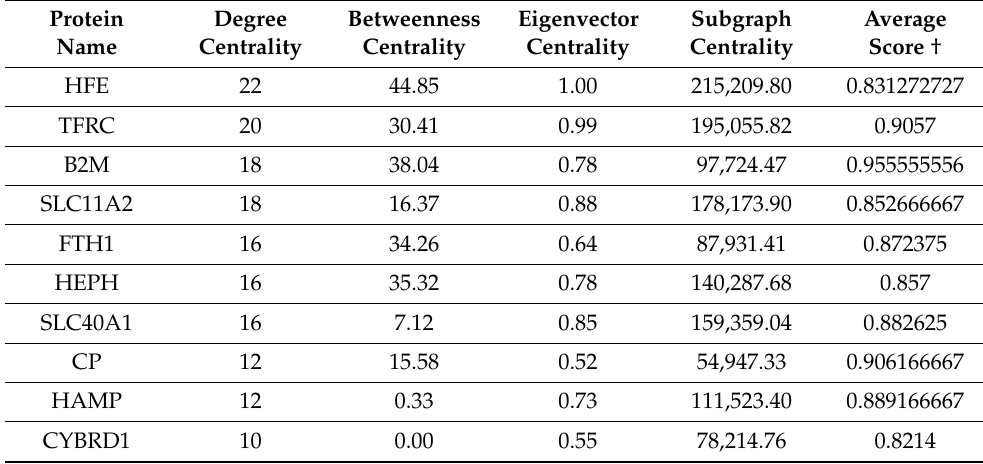
Table 3. Identification of hub-proteins based on network topology.